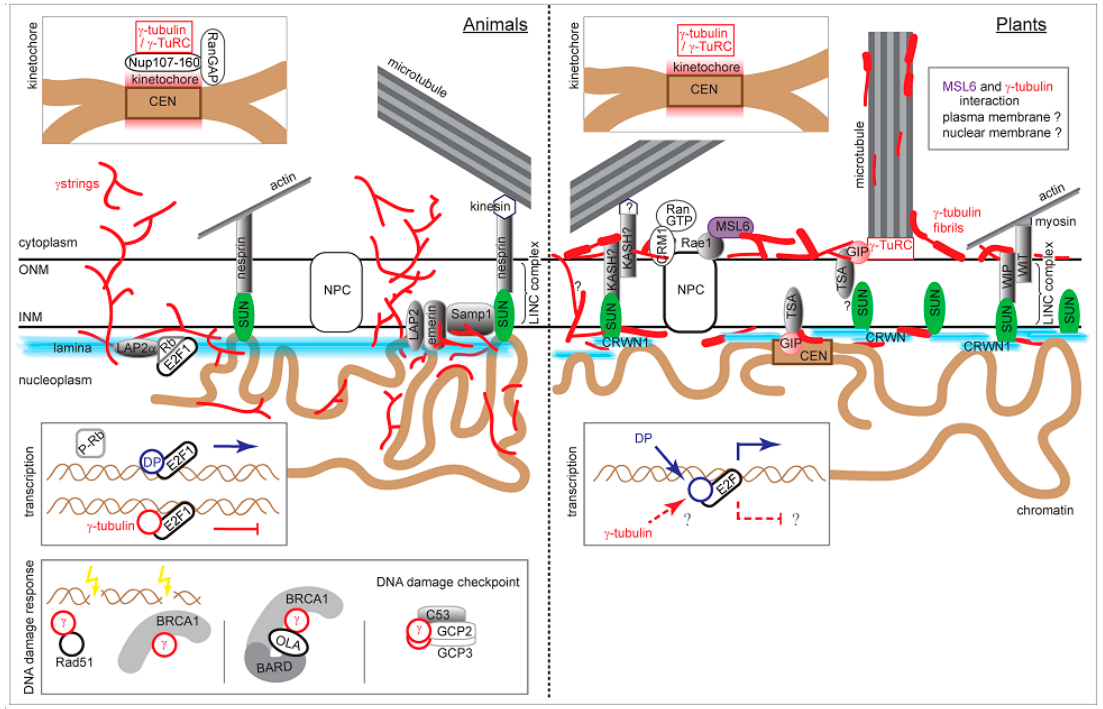
Figure 2. The graphical summary of nuclear γ‐ tubulin interactions and functions in animal and plant cells. Particular sections are based on published data or modified according to the cited